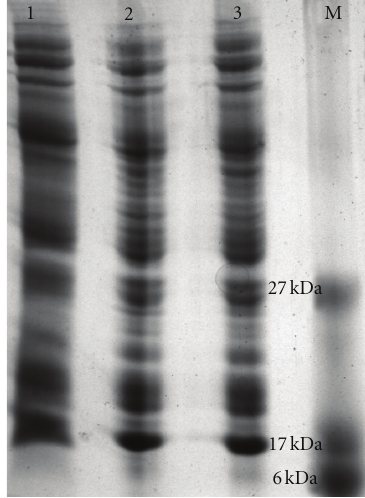
Figure 2: In vitro translated protein products. Lane M: ultra low- range peptide molecular weight marker, Lane 2: product of in vitro translation of pGEpmt, Lane 3: negative control ( E. coli DH5 α - pGEM).